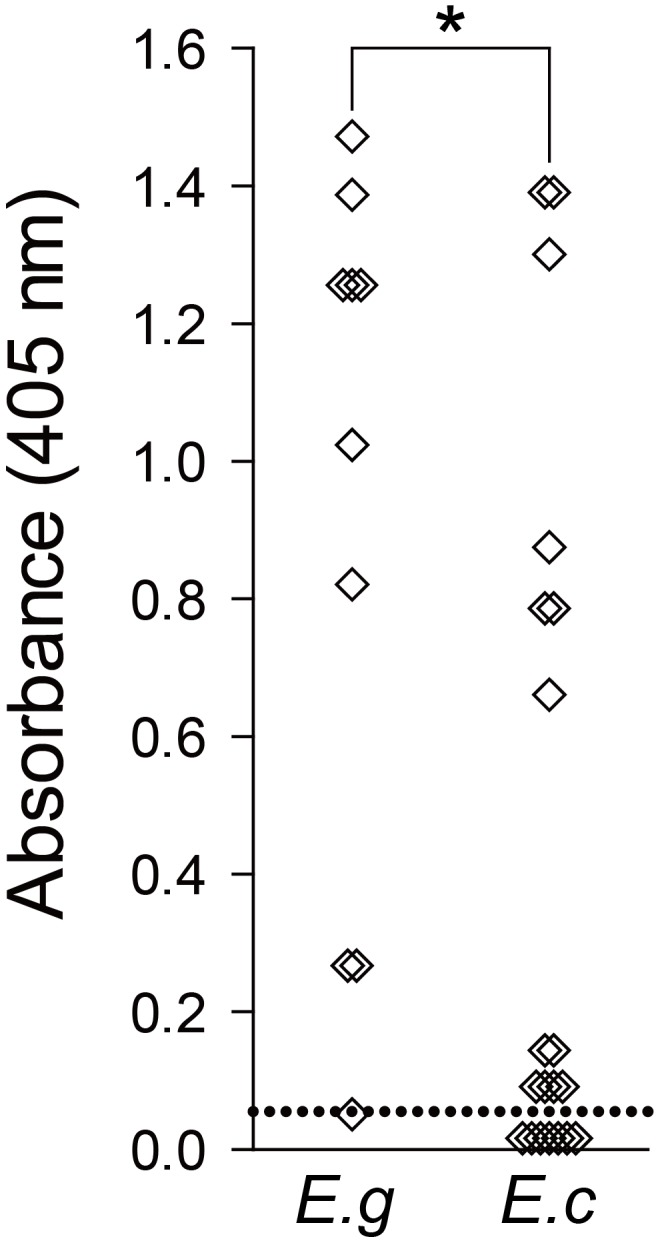
Results of ELISA with rEmAgB for CE cases infected with E. granulosus s.s. (G1) (n  =  10) and E. canadensis (G6/7) (n  =  20).The cut-off OD value was 0.055, and was indicated by the dotted line. E.g:: E. granulosus s.s. (G1) case serum samples, E.c.: E. canadensis (G6/7) case serum samples. *: p  =  0.0137